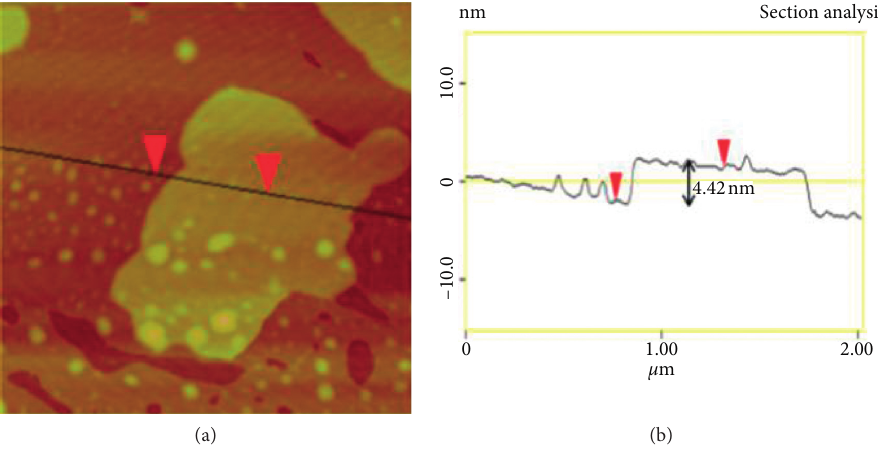
Figure 19: AFM image and height profile of MoS